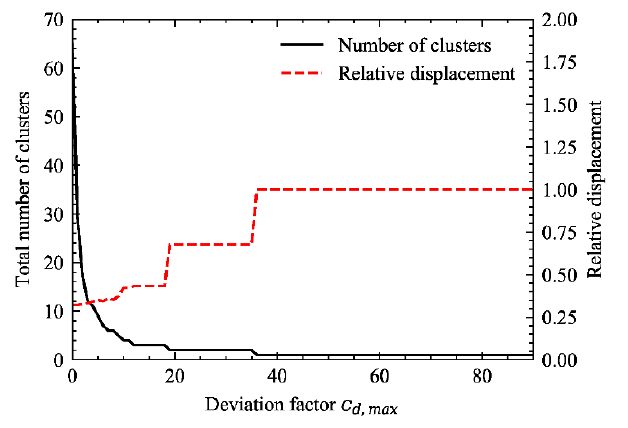
Figure 9. Total number of clusters that are required to satisfy the deviation factor c d,max (black) and the corresponding relative displacement (red) in relation to the max. displacement.